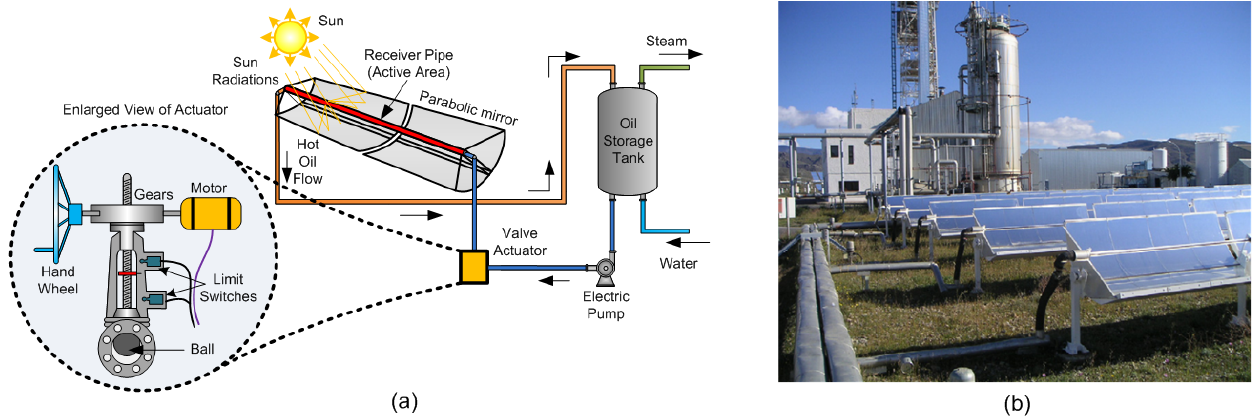
Figure 5. Valve actuator for distributed solar collector field: ( a ) Schematic of plant, ( b ) the ACUREX parabolic-trough-distributed solar field collector